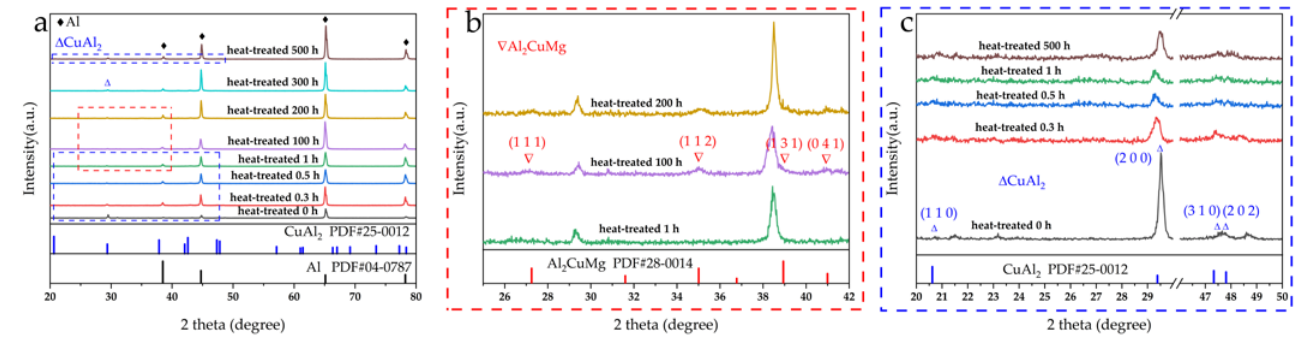
Figure 3. ( a ) XRD patterns of 2024 Al, with heat-treated time, ranged from 0 h to 500 h at 160 °C; ( b ) the red dotted area in Figure 3a; ( c ) the blue dotted area in Figure 3a.